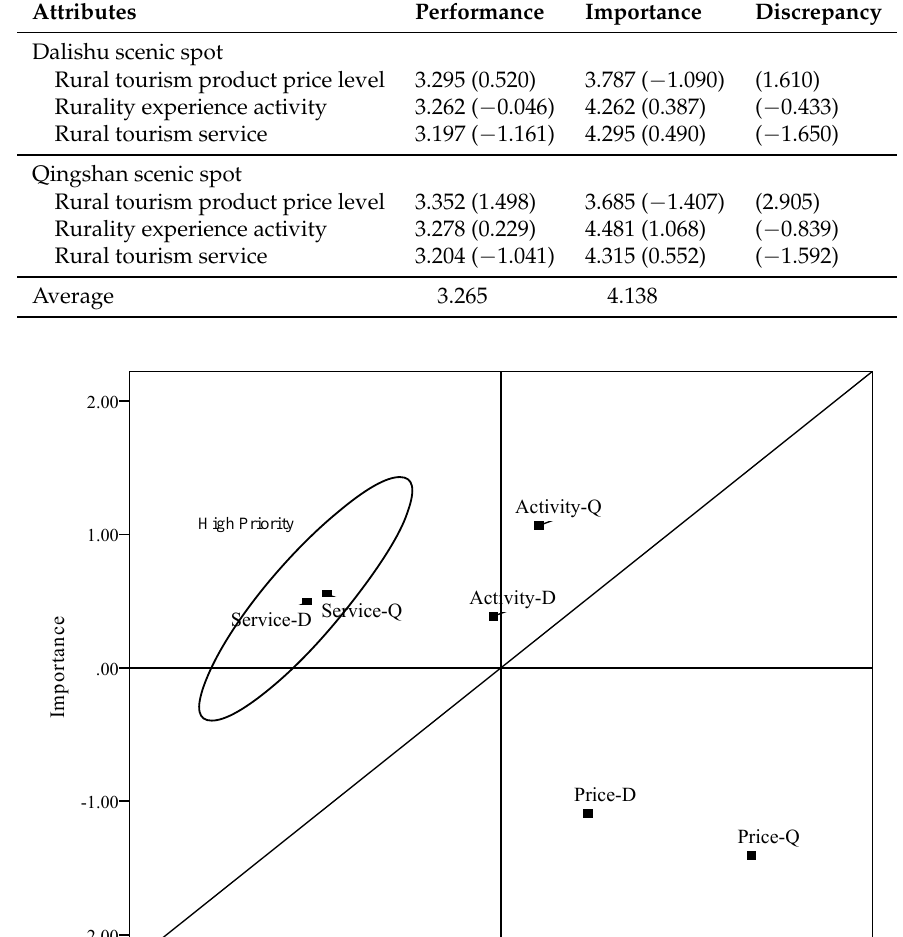
Table 7. Directly derived importance and performance of rural tourism products’ attributes.